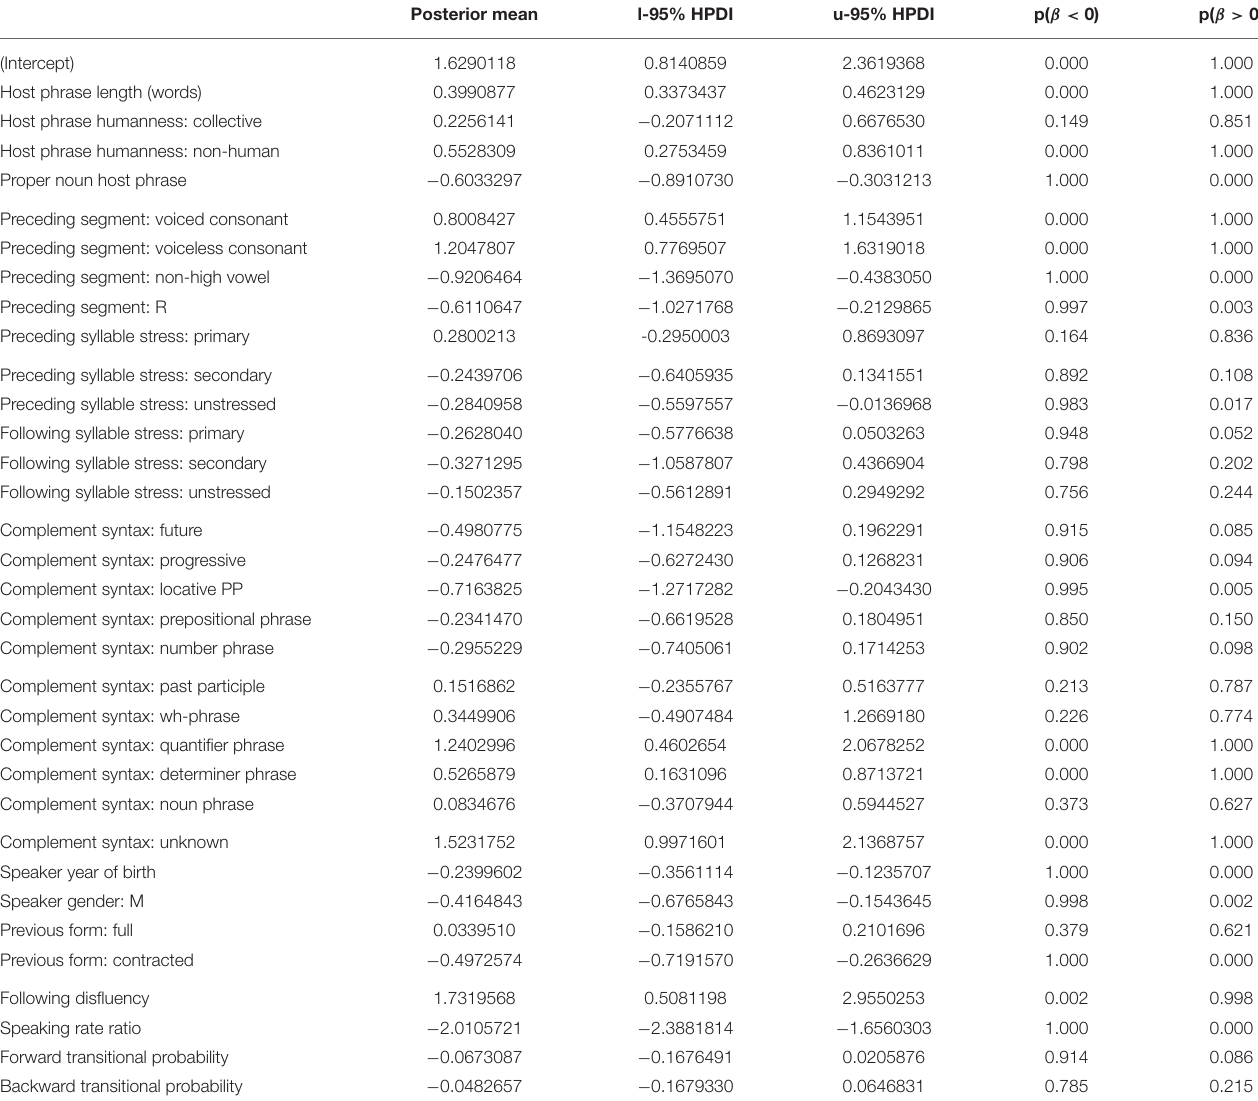
TABLE 3 | Model estimates for predictors influencing is